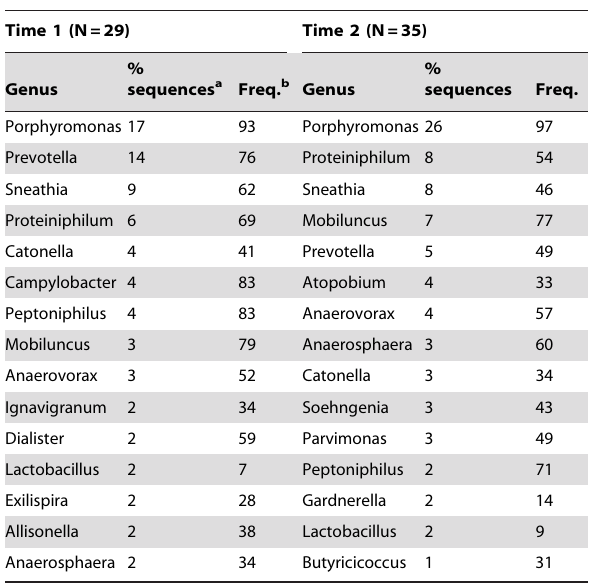
Table 1. Prevalence of Bacteria Genera in Rhesus macaques.